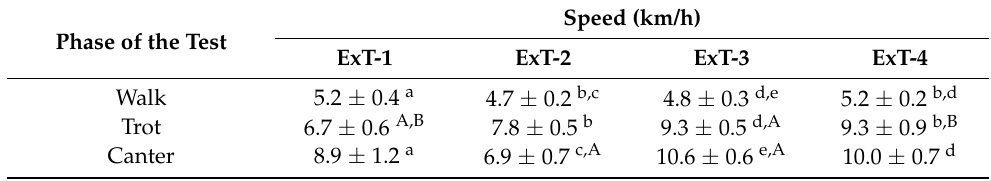
Table 3. Mean gait speed achieved during exercise in tests 1 to 4 (ExT-1 to ExT-4). Phase of the Test Walk Canter